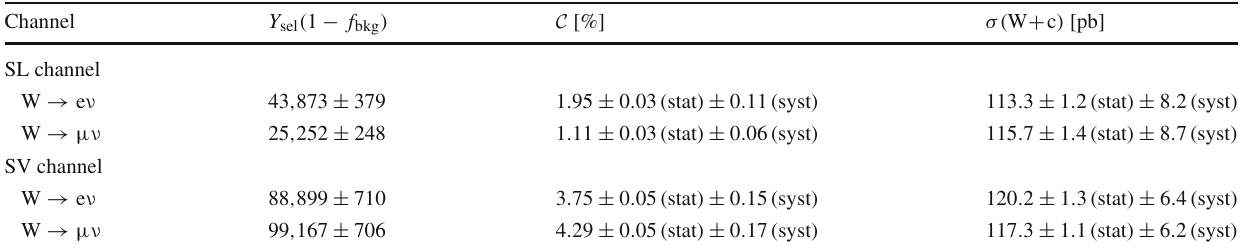
Table 4 Results in the SL (upper) and SV (lower) channels for the W → e ν and W → μν decays separately. Here Y sel ( 1 − f bkg ) is the estimate for the signal event yield after background subtraction, C is